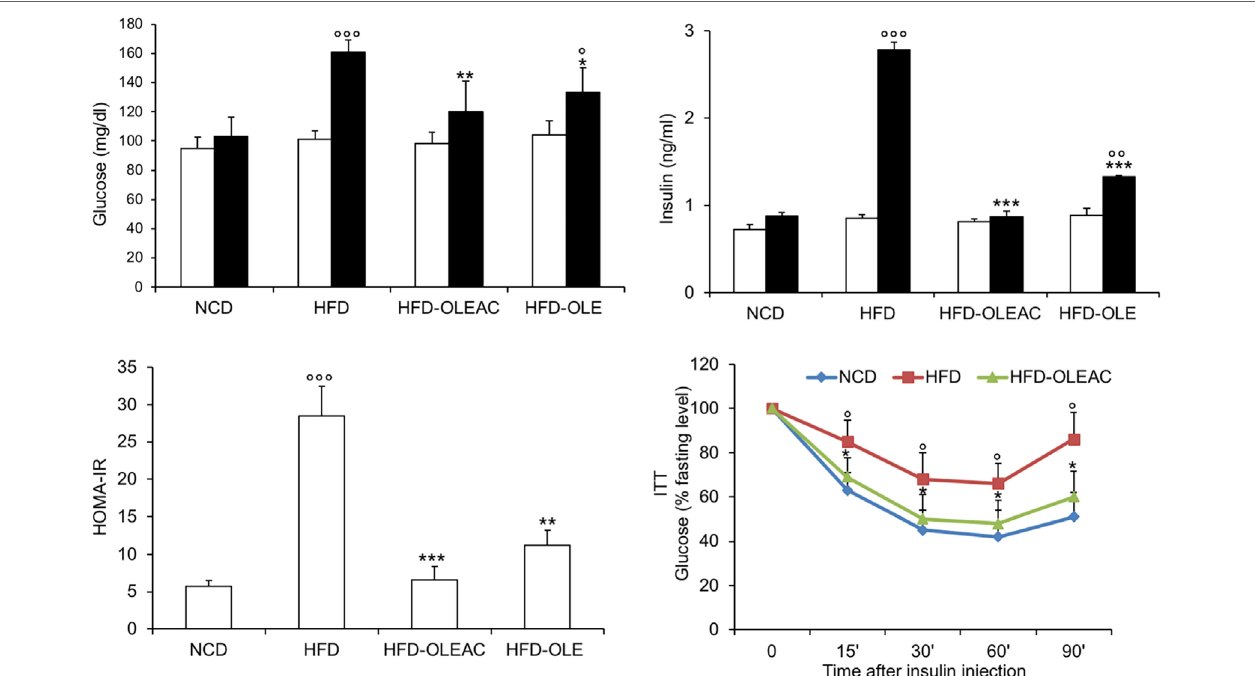
FigUre 2 | Effects of oleacein on insulin resistance. Fasting plasma glucose and insulin levels were measured at beginning (white bars) and at the end (black bars) of 5 weeks of treatment with oleacein (HFD-OLEAC) or oleuropein (HFD-OLE). Homeostatic model assessment of insulin resistance (HOMA-IR) was calculated thereafter. Insulin tolerance test (ITT) in NCD, high-fat diet (HFD), and HFD-OLEAC mice ( n = 4–6 per group). Values are expressed as mean ± SD. * p < 0.05, ** p < 0.01, *** p < 0.001 vs HFD group. ° p < 005, °° p < 0.01, °°° p < 0.001 vs NCD.